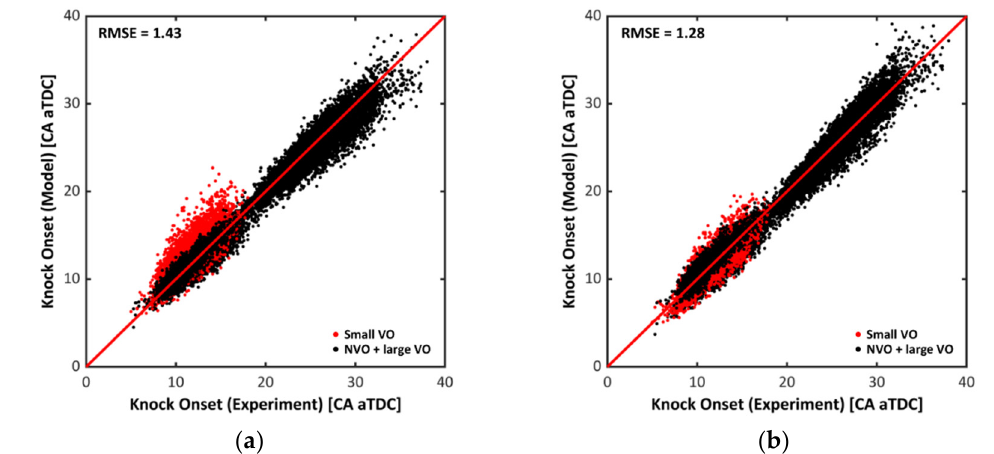
Figure 14. Results of knock prediction models: ( a ) previous studies; ( b ) present